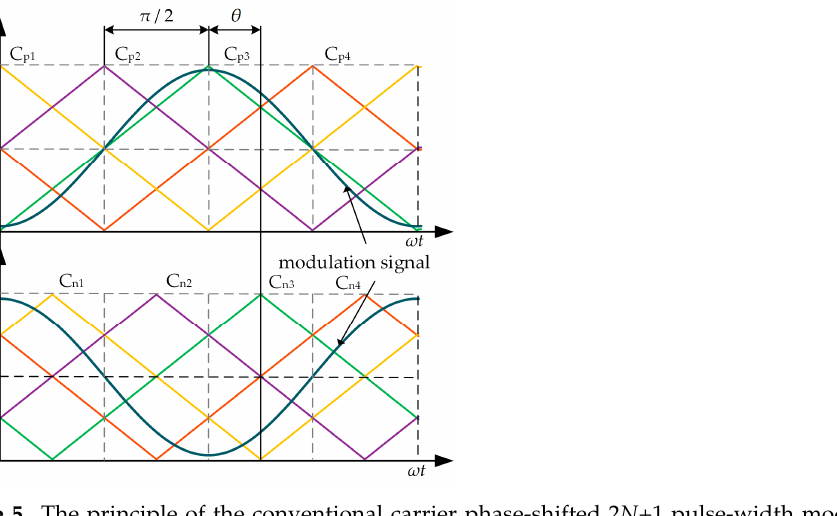
Figure 5. The principle of the conventional carrier phase-shifted 2 N +1 pulse-width modulation approach ( N = 4).